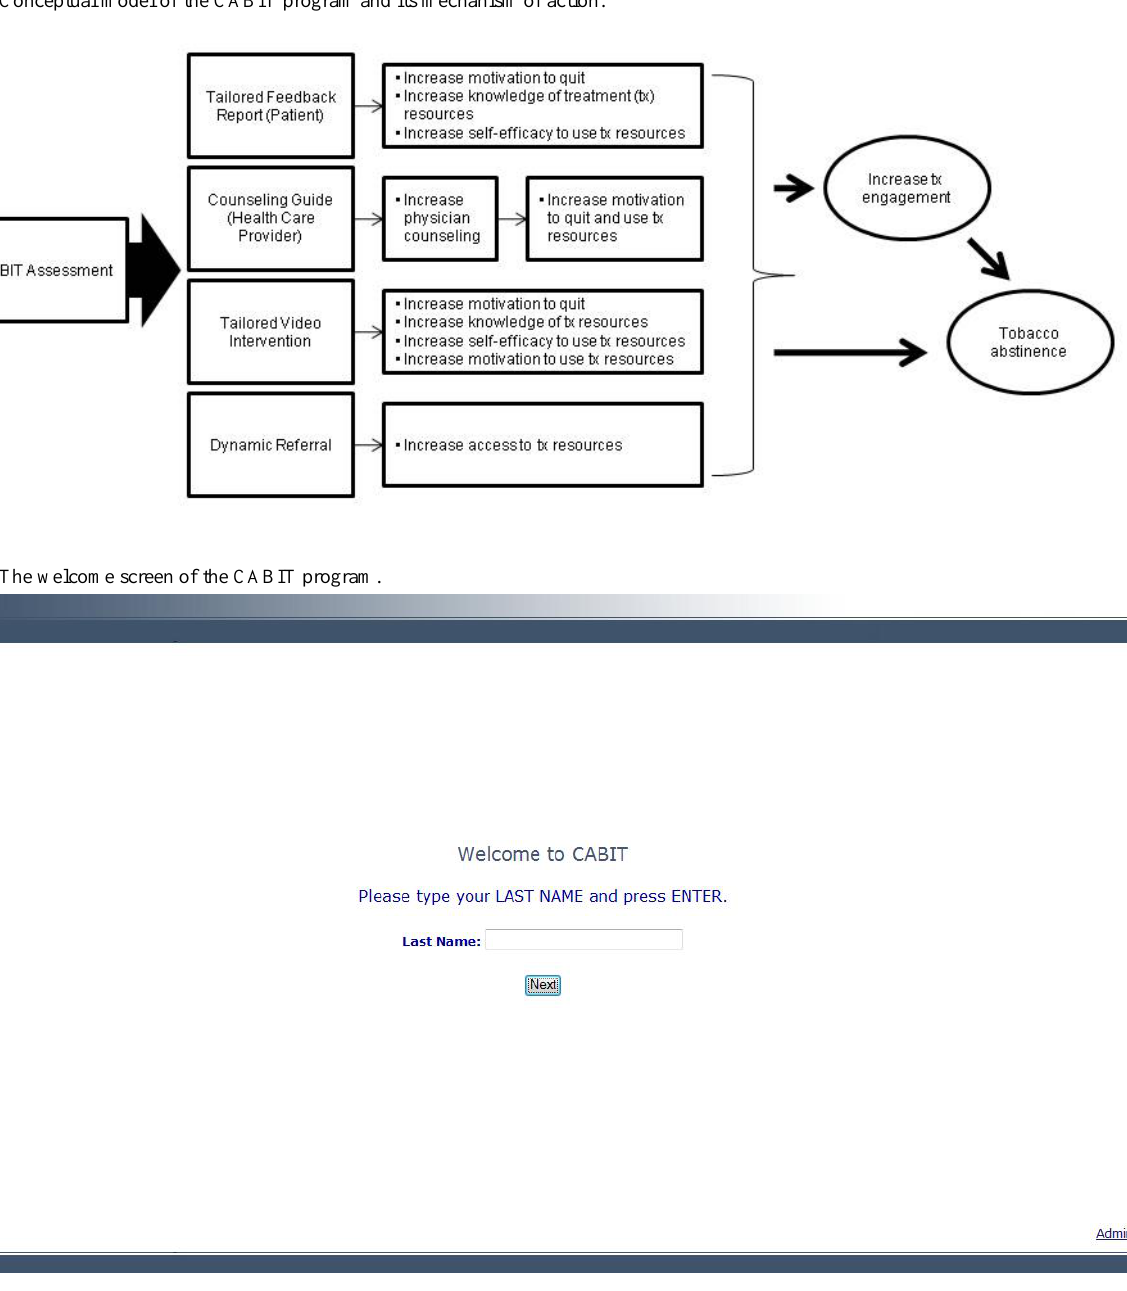
Figure 1. Conceptual model of the CABIT program and its mechanism of action.